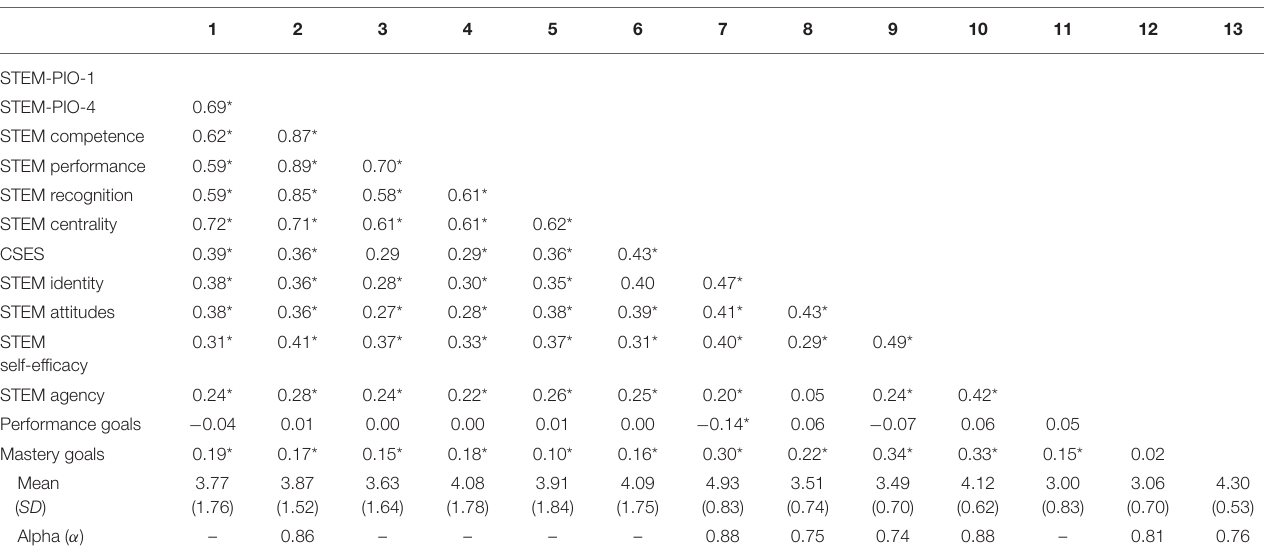
TABLE 7 | Descriptive statistics for measured variables in study